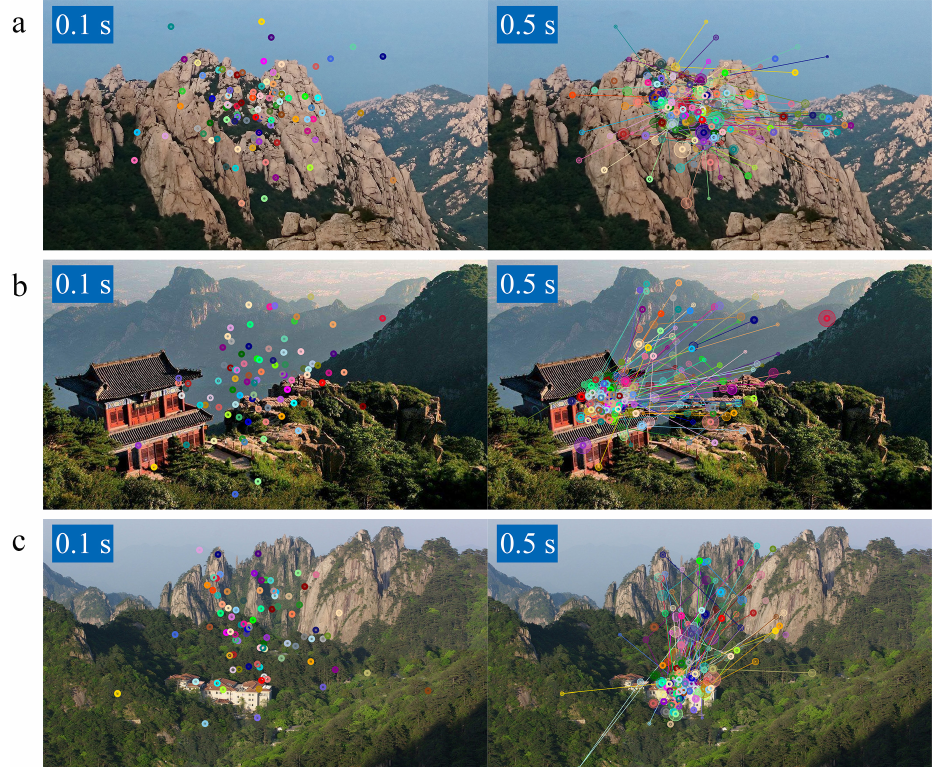
Figure 4. Scan path maps of three types of landscapes at 0.1 s and 0.5 s: ( a ) the natural landscape, ( b ) the temple landscape, and ( c ) the hotel